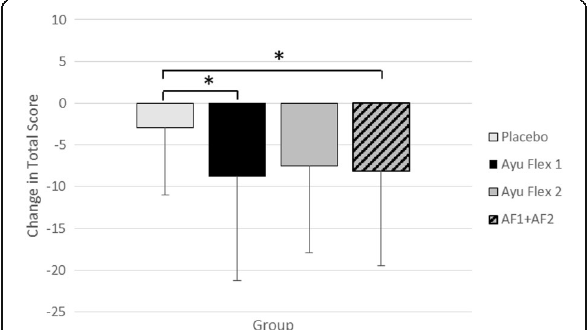
Fig. 6 Mean ± SD changes in Total mWOMAC scores. Significant differences were noted between the AF1 group ( p = 0.047) and when the two Active Groups ( p = 0.042) were combined vs. the Placebo group